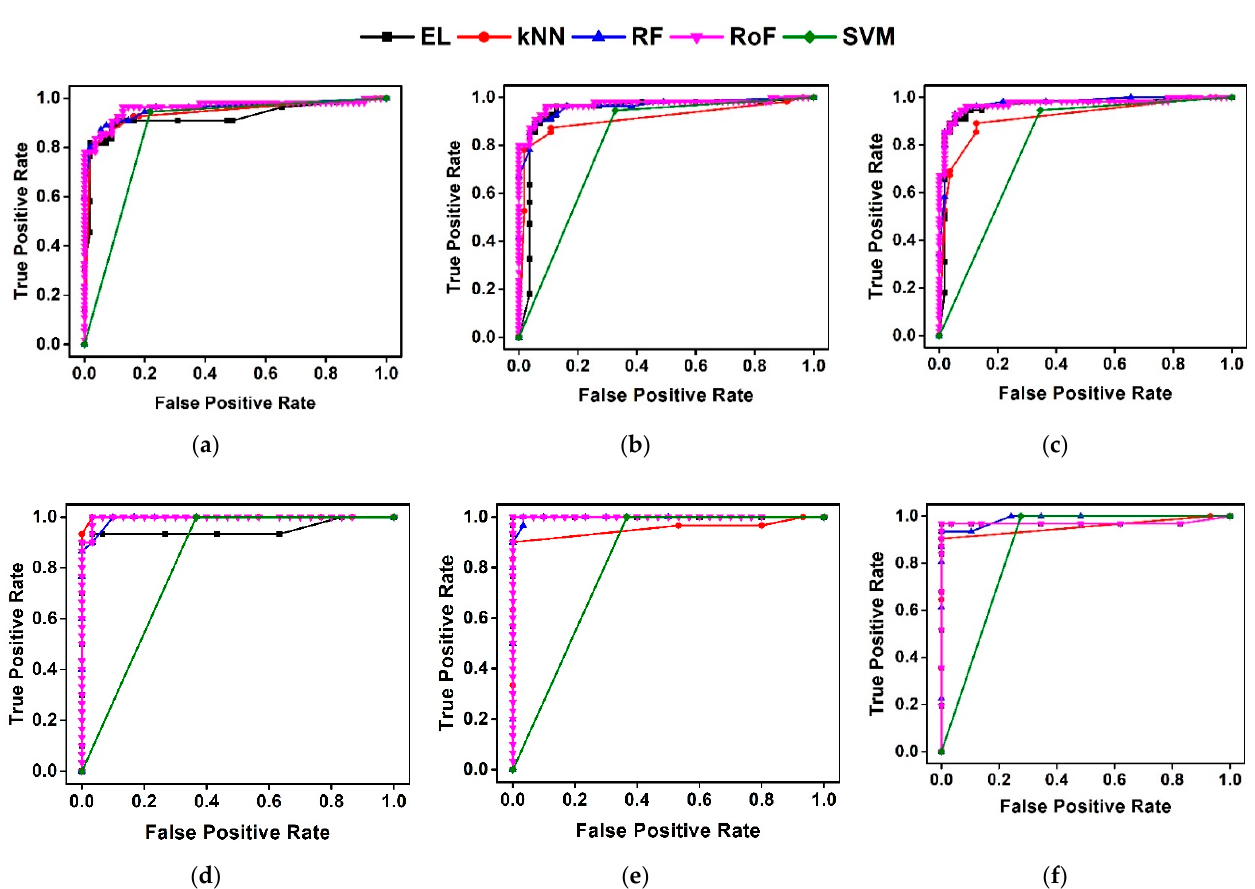
Figure 8. The average receiver operating characteristic (ROC) plots represent the performance of the classifiers for the DSA feature obtained using |𝕍| = 3,5,7 with 𝑊 = 3 for AFPDB ( a – c ) and AFTDB ( d – f ). Table 5. The average F (%) for varied |𝕍| in two databases. Bold values indicate the best performance in a group.